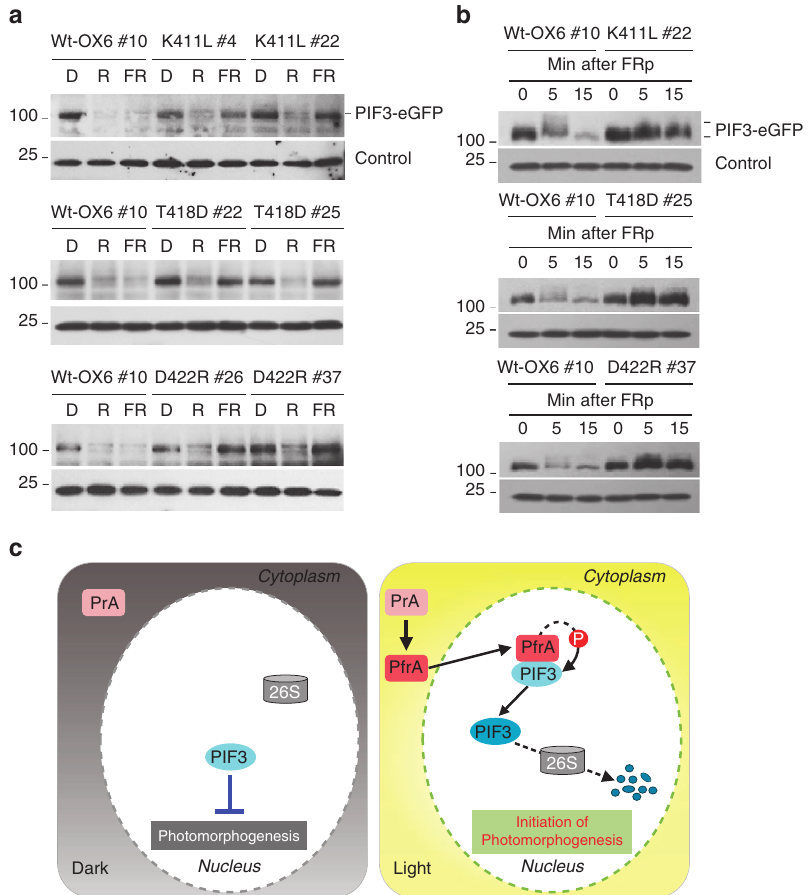
Figure 6 | Far-red light-mediated phosphorylation and degradation of PIF3 is prevented in transgenic plants with AsphyA kinase mutants. ( a ) PIF3 degradation under different light conditions. 4-day-old dark-grown seedlings were exposed to either cR (10 m molm (cid:3) 2 s (cid:3) 1 ) or cFR (10 m molm (cid:3) 2 s (cid:3) 1 ) for 30min and 2h, respectively. Loading controls are shown in the lower panels. ( b ) Far-red-induced phosphorylation of PIF3. Four-day-old dark-grown seedlings were exposed to FRp (7,500 m molm (cid:3) 2 ) and incubated in the dark for the time indicated before collecting for protein extraction. ( c ) A proposed model for the function of phyA as a protein kinase. For simplicity, PIF3 and phyA are depicted in this model as monomers, but they exist as dimers. In the dark, PIF3 proteins accumulate in the nucleus and regulate the expression of light-responsive genes to prevent photomorphogenesis. In the light, we propose that PfrA in the nucleus interacts and phosphorylates PIF3 directly, which induces PIF3 degradation via the ubiquitin/26S proteasome protein- degradation pathway. Thus, PIF3 phosphorylation by phyA and its subsequent degradation might induce the signal for the initiation of photomorphogenesis. 26S, 26S proteasome complex; P, phosphate; PfrA, Pfr form of phyA; PrA, Pr form of